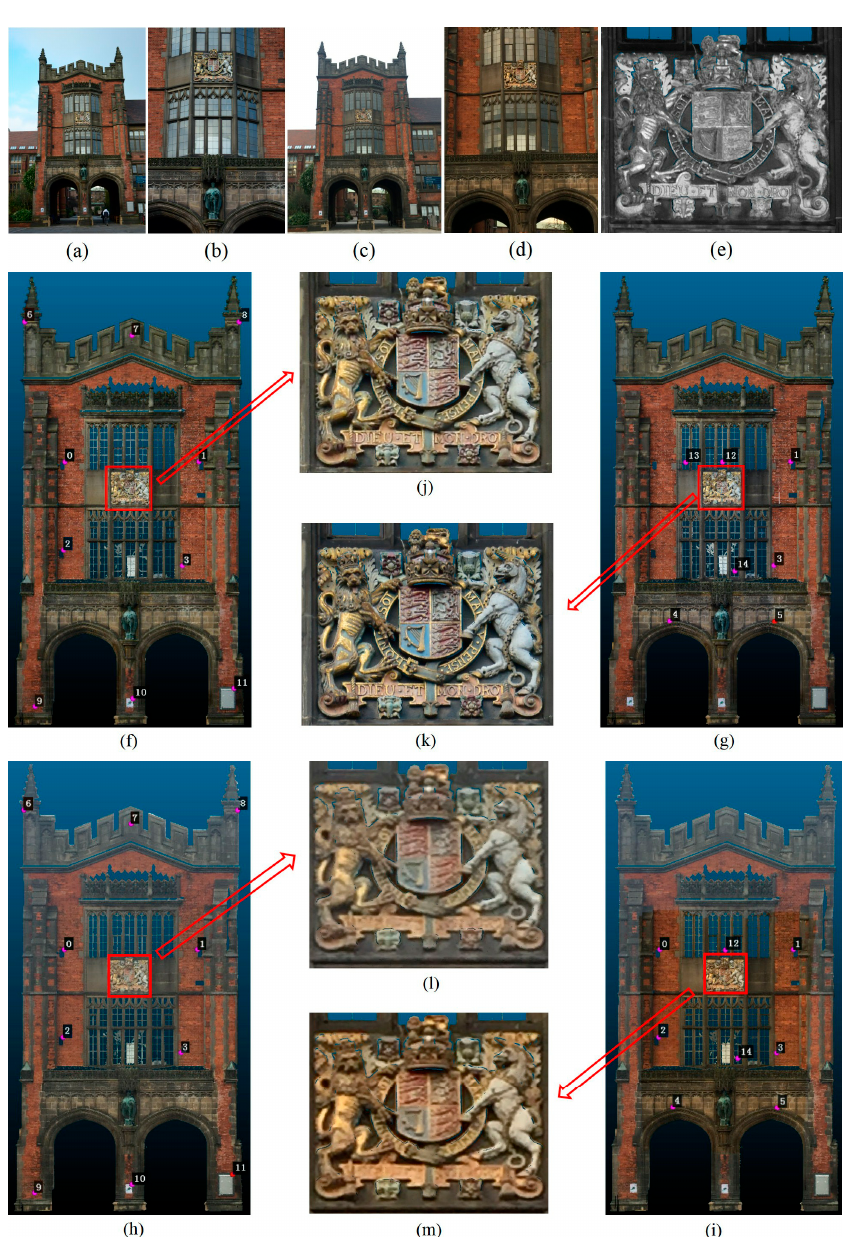
Figure 7. Photos and textured point cloud products. ( a ) Nikon 1 J4 image (f = 16.8 mm); ( b ) Nikon 1 J4 image (f = 29.4 mm); ( c ) iPhone 6 image (f 35 = 46 mm); ( d ) iPhone 6 image (f 35 = 92 mm); ( e ) The original point cloud of the central feature of the King Edward VII façade. ( f – i ) Point clouds of the King Edward VII façade, textured with images ( a ), ( b ), ( c ), ( d ) respectively; ( j – m ) The detailed texture on different point